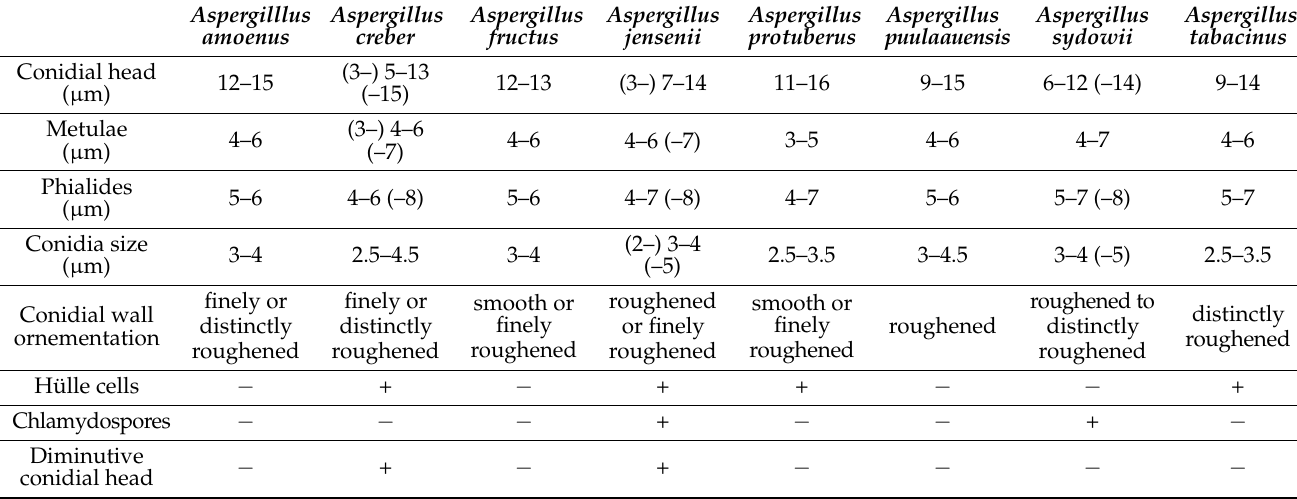
Table 2. Summary of microscopic